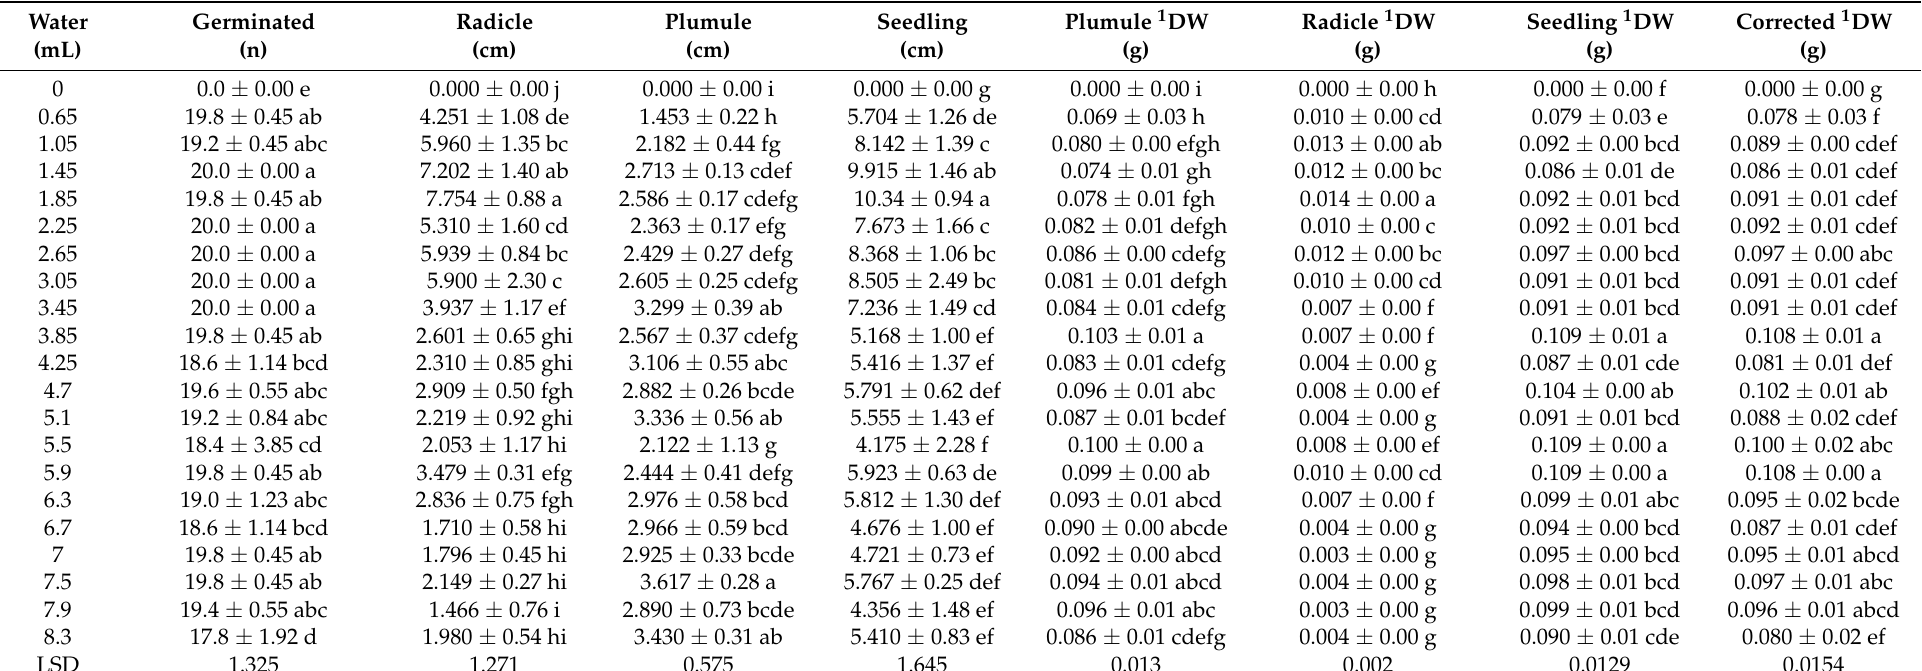
Table 2. Mean germination and seedling growth values for the different amounts of water based on